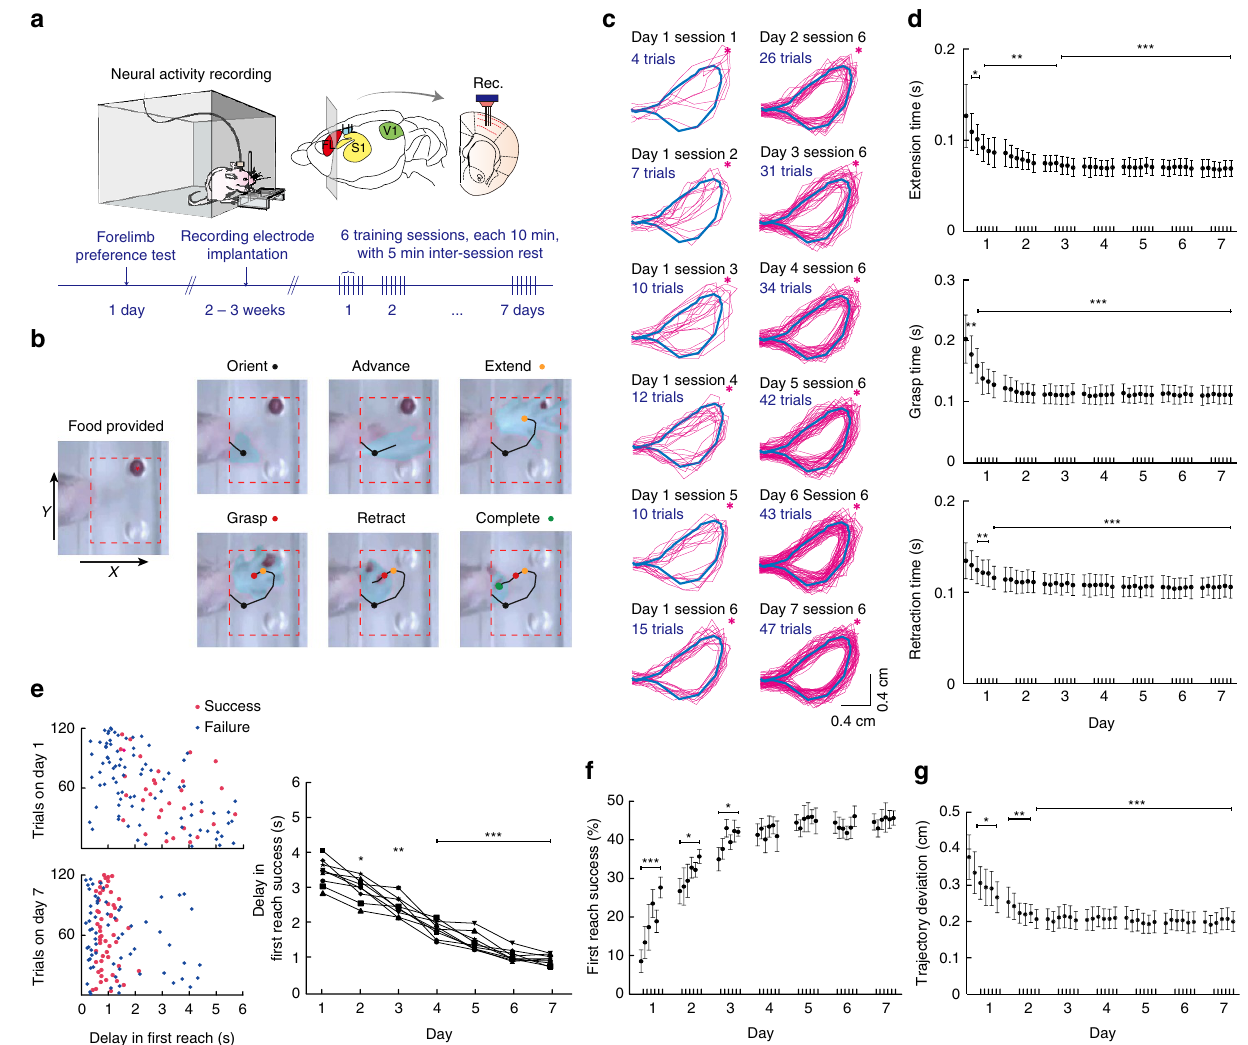
Figure 1 | Forelimb reaching for food training and simultaneous recording from L5b neurons in M1. ( a ) Schematics of experimental paradigm. Neural activities in L5b were recorded during forelimb food-reaching task training over 7 days by multi-channel recording electrode array (Rec.). FL and HL: forelimb and hindlimb territories of M1; S1: primary somatosensory cortex; V1: primary visual cortex. ( b ) Six phases of a first reach success trial captured by camera and the forelimb trajectory tracked automatically (see Methods). ( c ) The evolution of more uniform forelimb trajectories (pink) in first reach success trials. The reference expert trajectory is shown in blue colour. Red asterisk denotes the position of food pellet. ( d ) The duration of forelimb extension (upper panel), grasping (middle panel) and retraction (lower panel) in first reach success trials. The timing of reaching action shortened significantly in day 1 and exhibited further decrease in day 2 and 3, and remained steady thereafter. Mean ± s.d. * P o 0.05; ** P o 0.01; *** P o 0.001, one-way repeated measures ANOVA, n ¼ 9. ( e ) Left, delay in first reach attempt quantified by the time interval between food provision and the ‘orient’ position of forelimb on days 1 and 7 (120 consecutive trials each from a single representative rat). Right, learning associated shortening in the delay in first reach success attempt. Mean ± s.d. of delay in first reach success trials: day 1: 3.44 ± 0.37s; day 7: 0.96 ± 0.14s, P ¼ 2.51 (cid:2) 10 (cid:3) 6 ; * P o 0.05; ** P o 0.01; *** P o 0.001, all compared with day 1; one-way ANOVA, 9 rats; first reach failure trials: day 1: 2.31 ± 1.55s; day 7: 1.45 ± 1.20s, P ¼ 0.012; one-way ANOVA, 9 rats. ( f ) Training-dependent improvement in first reach success rate (see text). ( g ) Evaluation of forelimb trajectory spatial variance as the averaged distance integrated over time between the actual trajectories in first reach success trials (pink) and the reference expert trajectory (blue) shown in d . Mean cumulative Euclidean distance ± s.d., day 1 session 1: 0.375 ± 0.061cm; day 1 session 6: 0.265 ± 0.042cm, P ¼ 0.0173; day 2 session 1: 0.252 ± 0.041cm, P ¼ 0.0052; day 2 session 6: 0.205 ± 0.026cm, P ¼ 7.85 (cid:2) 10 (cid:3) 4 ; * P o 0.05; ** P o 0.01; *** P o 0.001, all compared to day 1 session 1, one-way repeated measures ANOVA, n ¼ 9. To determine whether a unit was stable and represented measures of cluster quality, from both 16-channel microwire correct tracking of the same neuron over consecutive days, array and tetrodes. Specifically, the criteria for single-unit we computed four criterion scores: maximum time-shifted are: signal-to-noise ratio 4 4, isolation distance (ID) 39 Z 15, L-ratio r 0.2 (refs 40,41–43), and a clear refractory period linear correlation coefficient of spike waveform ( Max r , revealed by both inter-spike interval (ISI) distribution and auto- Fig. 2d), normalized spike peak-to-peak amplitude difference correlograms with 99.5% of events with ISI 4 2 ms (microwire ( D P amp ), dissimilarity score for inter-spike interval histogram array: Fig. 2a–c, Supplementary Fig. 2a–c; tetrode: Supplementary (ISIH), and dissimilarity score for autocorrelation histogram 44–47 Fig. 2d–f, see Methods). (see Methods). We fitted Gaussian mixture model to distributions NATURE COMMUNICATIONS|8:15834|DOI: